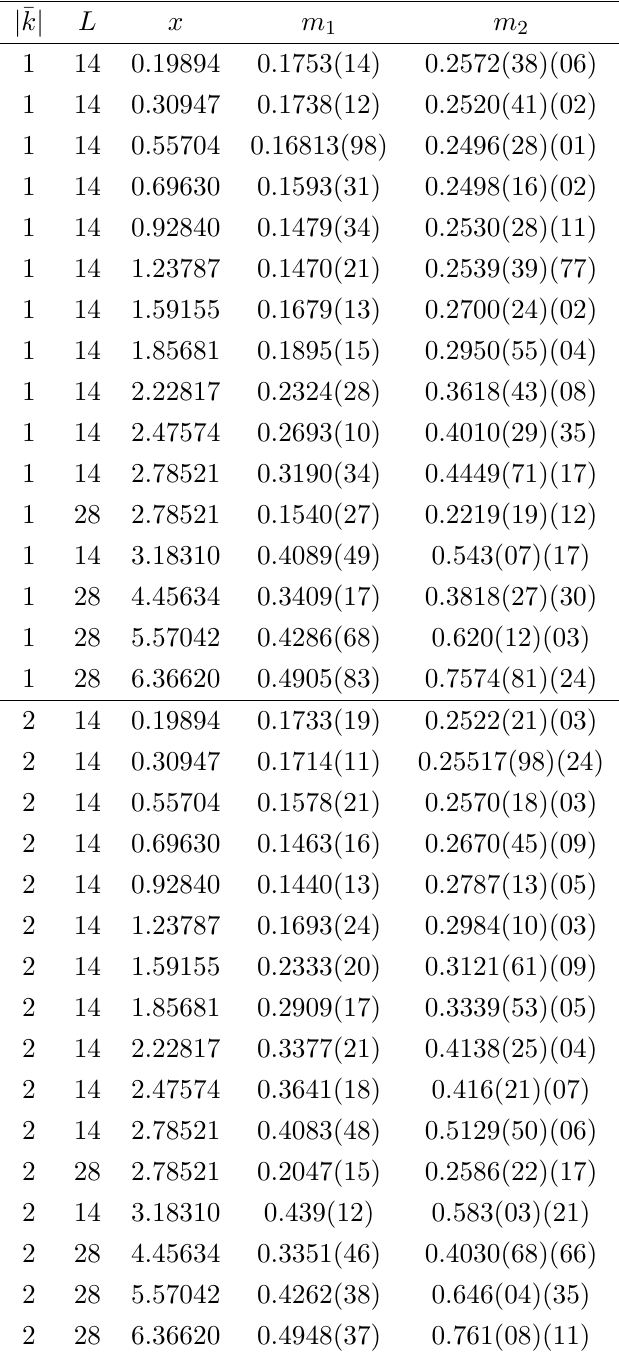
Table 18. Mass gap and next excited state energy (in lattice units) in the zero-electric (cid:13)ux scalar sector for